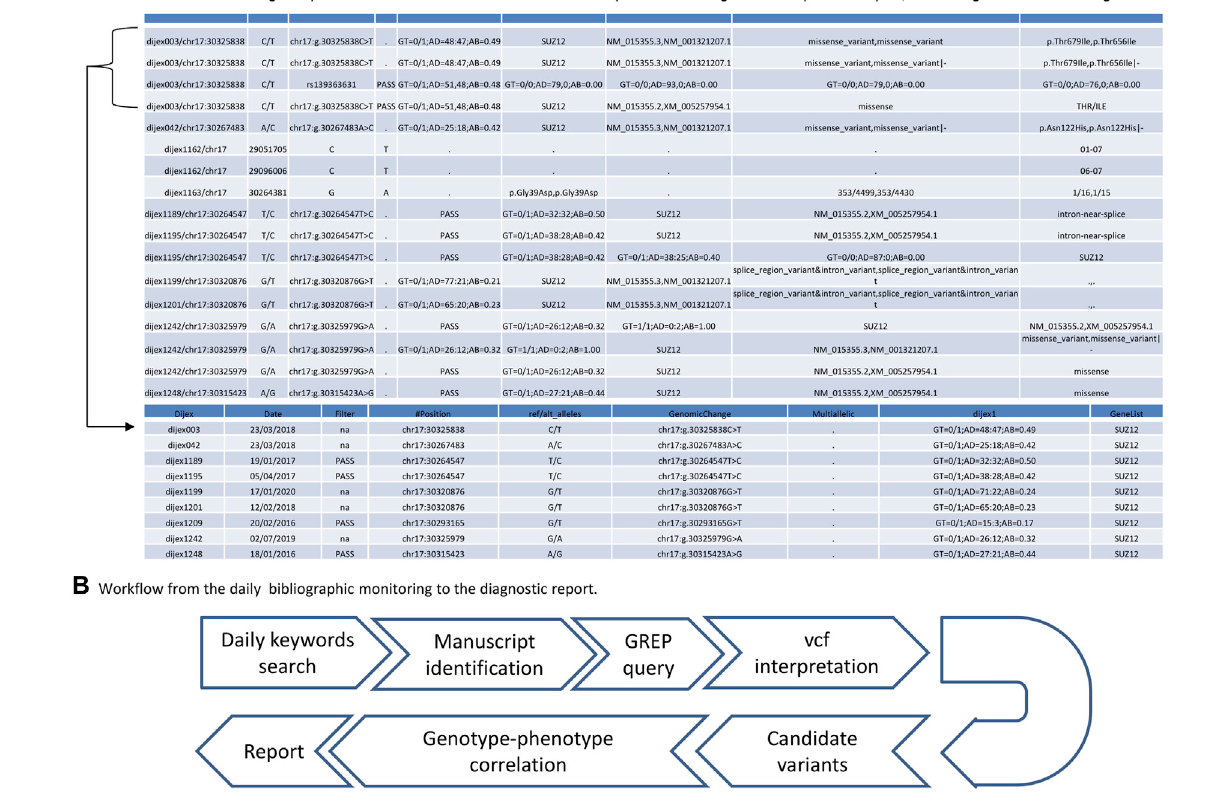
FIGURE 1 (A) Tabular fi lesproducedbyabasicGREPquery(top)andcustomscriptquery(bottom)for SUZ12 .Notetheabsenceofheaders,theduplicatelines, andthedisorderedcolumnsinthe fi leresultingfromthebasicGREPquery,whicharecorrectedintheversionoutputbythein-housescript. (B) Work fl ow of the fast GREP query